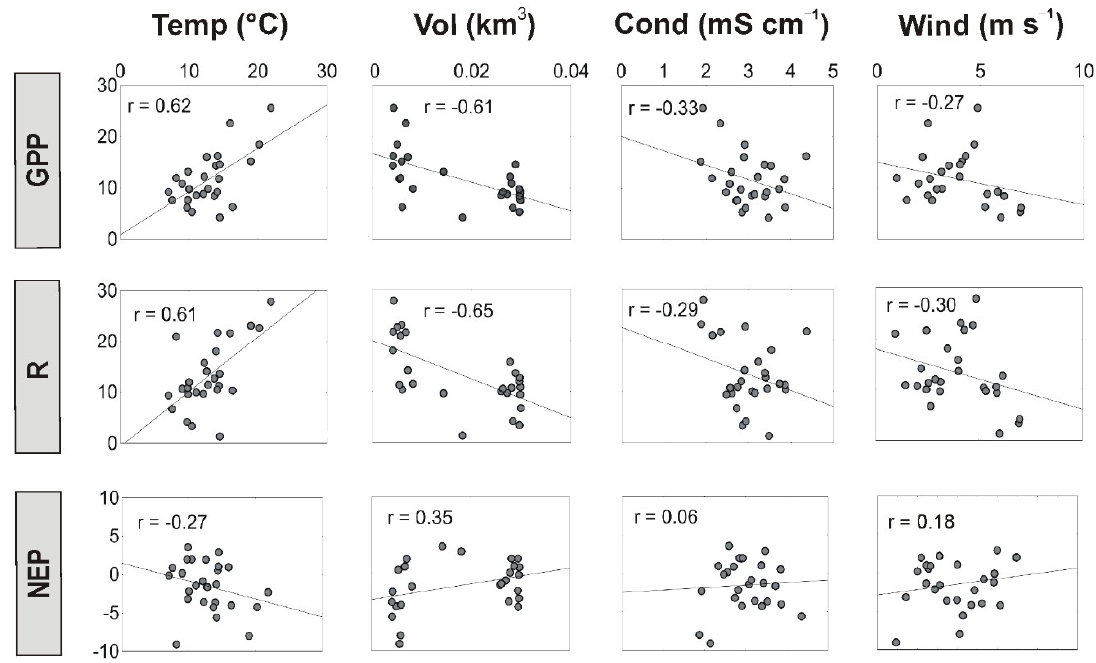
Figure 6. Correlation matrix relating the weekly averages for metabolic variables GPP: Gross primary production, R: community respiration, and NEP: net ecosystem production (mmol m − 3 day − 1 ) with the environmental variables Temp: water temperature ( ◦ C), Vol: lake volume (m 3 seg − 1 ), Cond: